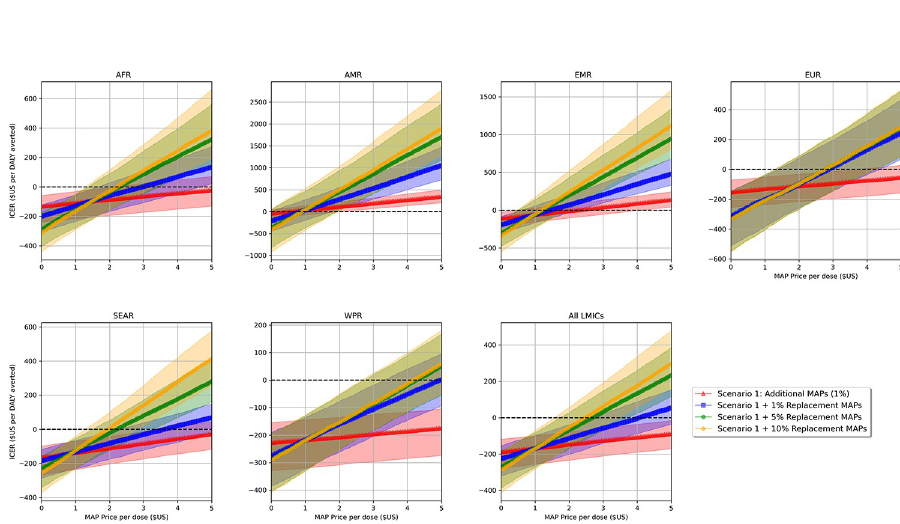
Fig 2. Incremental cost-effectiveness of MAPs at increasing price-per-unit values in each WHO region. Note: Shading represents interquartile range of 1000 model simulations. As ICER increases (ascends along the Y-axis), cost- effectiveness of MAPs decreases. Above dotted line indicates additional costs per DALY averted over the cohort lifetime, below indicates costs-saved per DALY averted over the cohort lifetime. Abbreviations: AFR: African WHO Region, AMRO: American WHO Region, DALY: disability-adjusted life years, EMRO: Eastern Mediterranean WHO region, EURO: European WHO Region, ICER: incremental cost-effectiveness ratio, LMIC: low- and middle-income countries, MAP: microarray patch, SEARO: Southeast Asian WHO Region, WHO: World Health Organization, WPRO: Western Pacific WHO